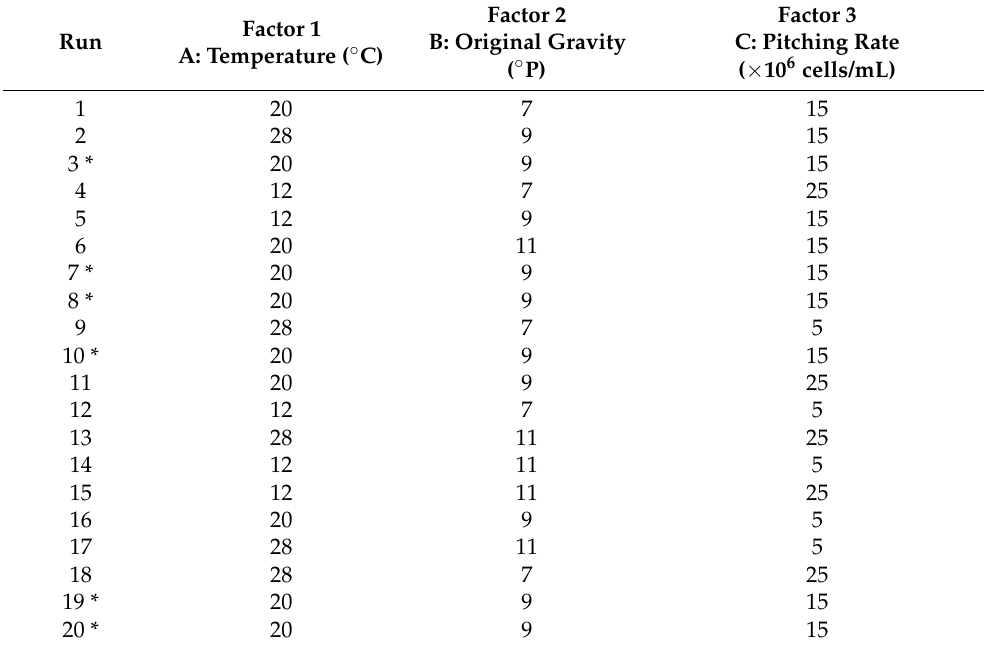
Table 1. Experimental design of response surface methodology (RSM) with face-centered, three- factorial (temperature, original gravity, and pitching rate) central composite design, and six